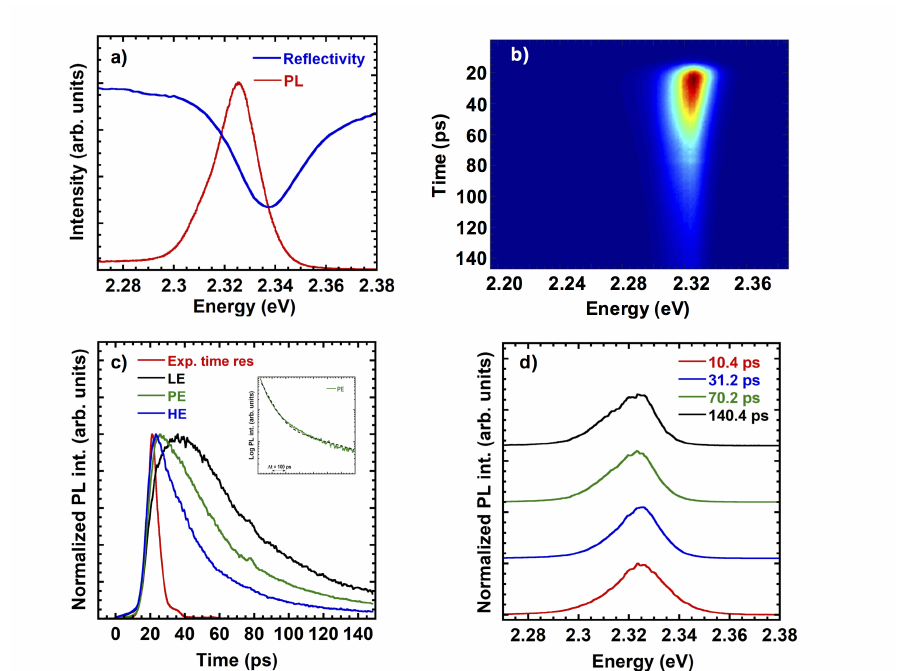
Figure 9. Photoluminescence spectra at 10 K. ( a ) CW PL and reflectivity spectrum. ( b ) Streak camera image of the PL. ( c ) Normalized PL decays at three different energies extracted from ( b ): HE-high energy side at 2.34 eV, PE-Peak energy at 2.325 eV, LE-low energy side at 2.31 eV. The red curve in ( c ) is the experimental time response. In the inset a fit of the PL decay (dashed line) at 2.325 eV is reported. ( d ) Time-resolved PL spectra extracted from ( b